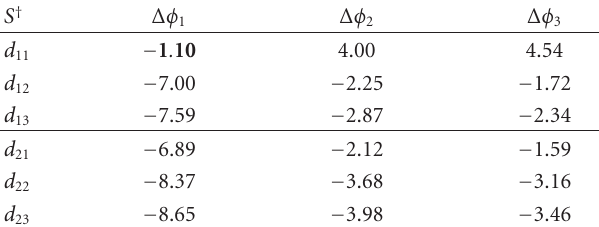
Table 4: Percentage relative error on the flux at position x 1 and time t = 10ms during transient T1 with di ff erent localizations of the adjoint source for the definition of the lpk model adopted. In bold, the result obtained when the adjoint source is located where the detector is (spatially and energetically).